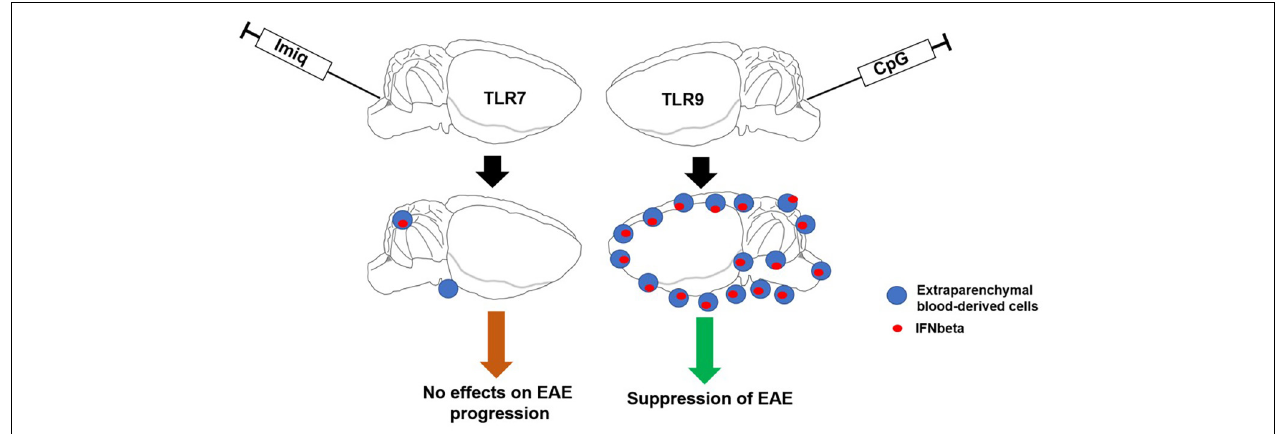
FIGURE 7 | Schematic illustrating the major findings from this study. Activation of TLR9 signaling pathways within the CNS induces IFN β production and recruitment of peripheral cells which contribute to suppression of EAE.